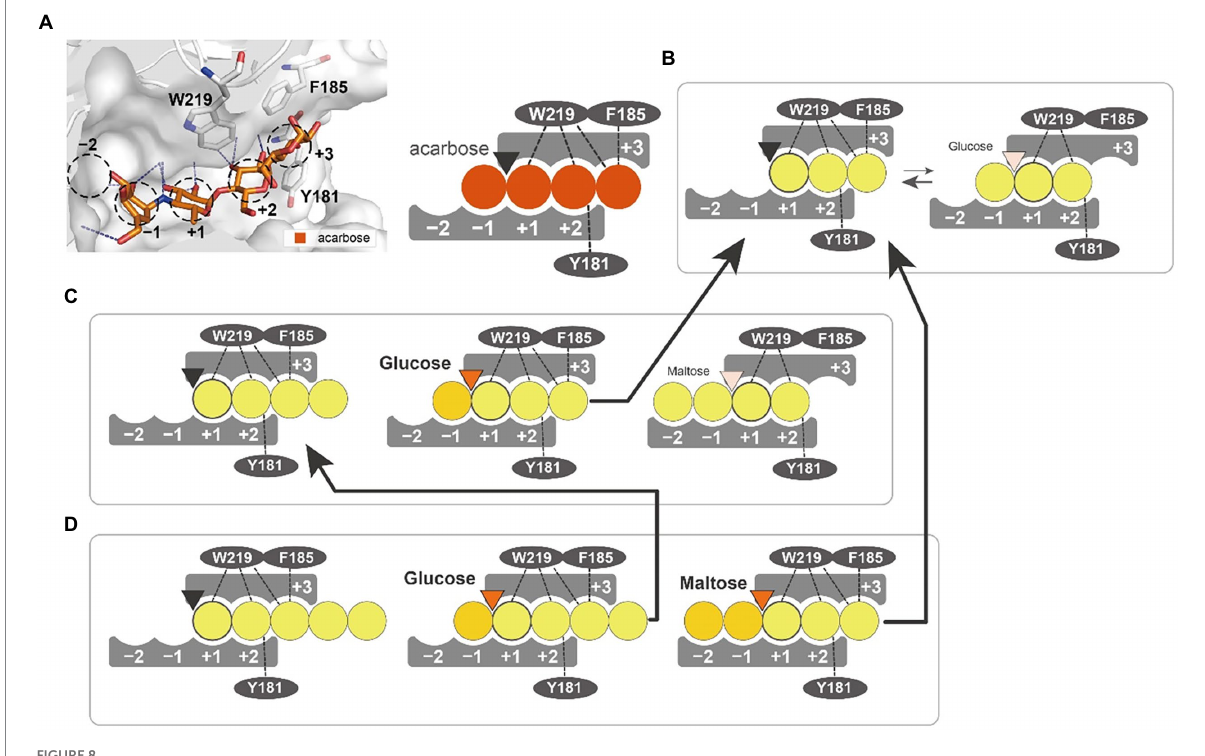
FIGURE 8 Substrate interaction of PSGT. (A) Glucose moiety-binding sites of PSGT, with acarbose. The − 1, +1, +2, and + 3 positions were determined from the structure of acarbose in the Thermococcus litorallis 4- α -glucanotransferase (PDB ID = 1K1Y). The glucose binding sites of the enzyme are illustrated as a figurative diagram of the enzyme and substrate. The interactions of ligands with Y181, F185 and W219 are illustrated as dashed lines. (B–D) Interaction of maltotriose (B) , maltotetraose (C) , and maltopentaose (D) with PSGT. The PSGT active site is depicted as a triangle and colored by its enzymatic status: black (inactive), orange (active), and pale orange (weakly active).